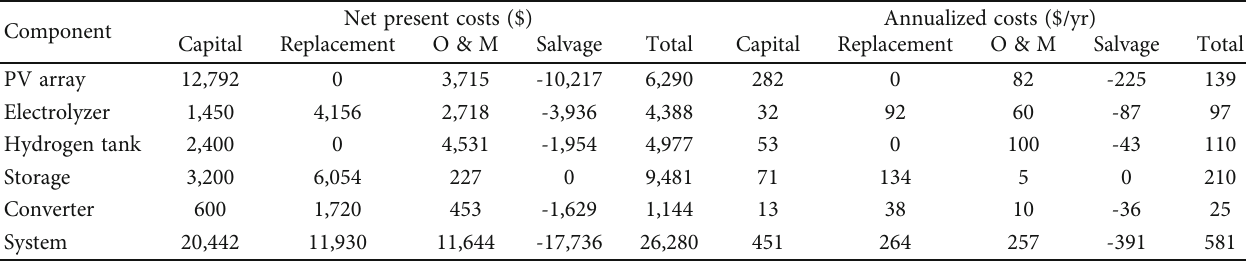
Table 9: Present worth and annualized value of all costs over 20 years.